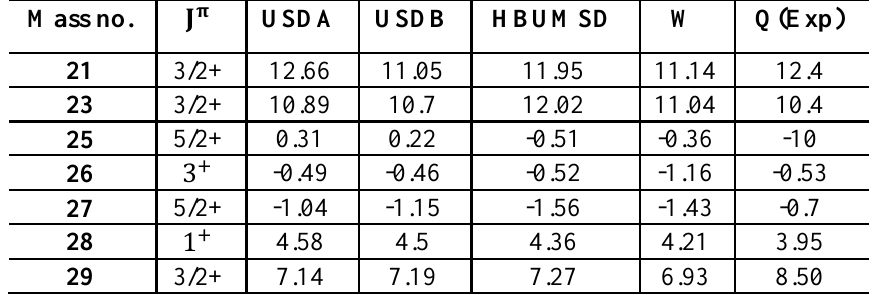
Table 3: The calculated electric quadrupole moments in e 2 fm 2 for Na-isotopes using different two-body effective interactions; USDA, USDB, HBUMSD and W in comparison with experimental data from Refs. [16,